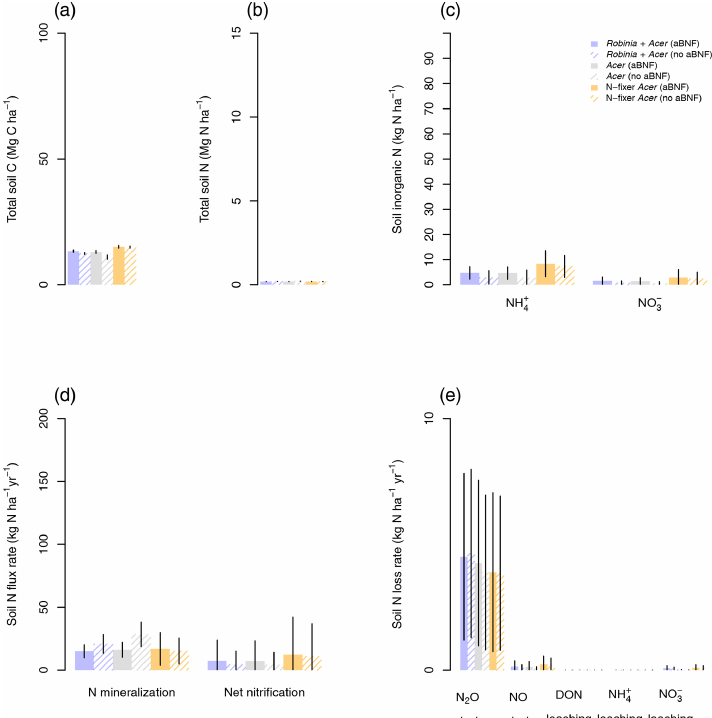
Figure D7. Simulated soil C and N pools, soil N fluxes, and soil N loss rates from LM4.1-BNF initialized with both Robinia and Acer , only Acer , and only N-fixer Acer , with and without asymbiotic BNF. (a) Simulated total soil C (depth 0–10cm). (b) Simulated total soil N (depth 0–10cm). (c) Simulated soil NH + and NO − (depth 0–10cm). (d) N mineralization rate and net nitrification rate (depth 0–10cm). (e) 4 3 Simulated N 2 O and NO emission rate and simulated dissolved organic N (DON), NH + , and NO − leaching rate. Simulated data are averaged 4 3 over the last 100 of the 300 years of simulation to reflect the site data which are from mature forests. Error bars indicate 2 standard deviations.